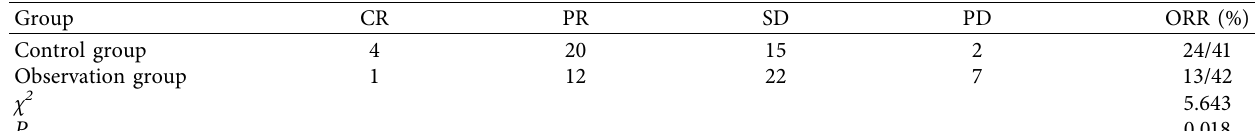
Table 2: Comparison of short-term curative efect between two groups of patients ( n � 44, %).